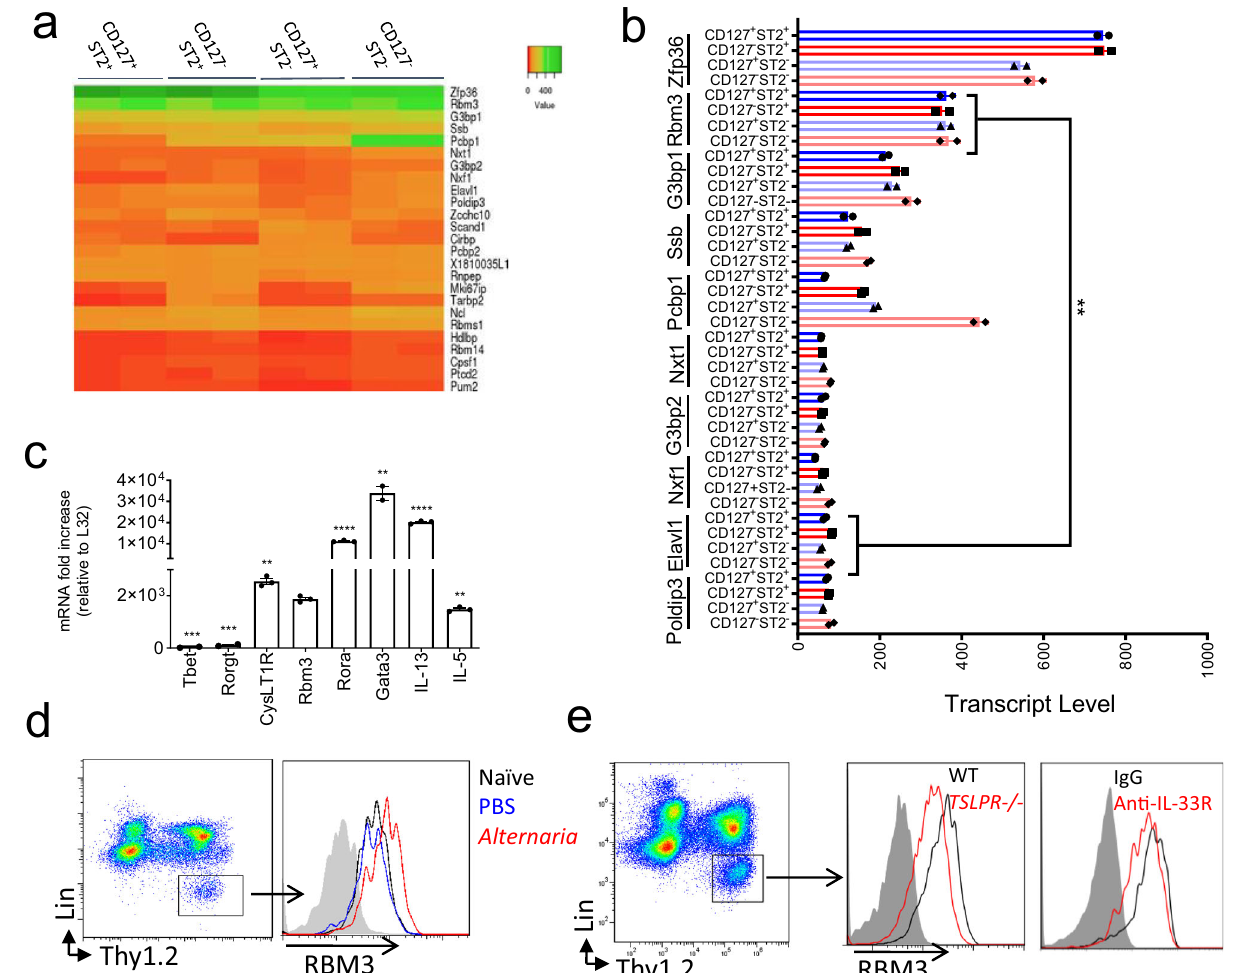
Fig. 1 | RNA-binding protein RBM3 is highly expressed by lung ILCs during fungal allergen exposure and is regulated by IL-33 and TSLP. a Wild-type mice werechallenged4timeswith50 µ g Alternaria overthespanof10daysandfourILC subsets (CD127 + ST2 + , CD127 − ST2 + , CD127 + ST2 − , CD127 − ST2 − ) were sorted and col- lected for RNA-seq. Heatmap showing the relative expression of the top 25 most highly expressed RBPs in the four ILC subtypes. RBPs involved in the cell cycle or splicing were excluded. Statistics were performed with Centroid linkage and Manhattanclustering. b Absolutetranscriptlevelsofthetop10RBPsinthefourILC subtypes. Statistics were performed with an unpaired t-test, two-tailed. Data representativeof2samples( p <0.01). c RBM3mRNAlevelsofILC2sincomparison